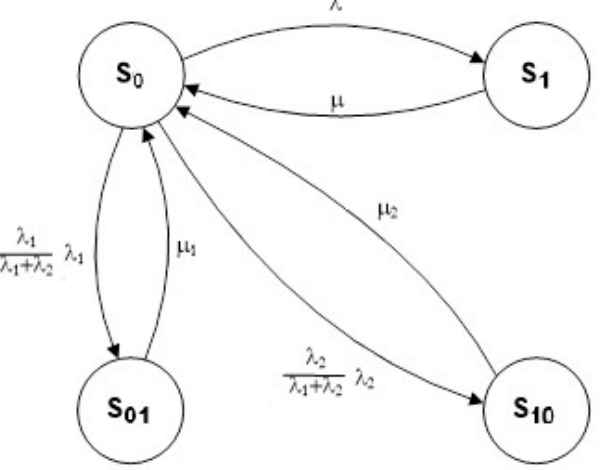
Figure 3. Diagram of the operation process of a wind equipment farm that is not provided with any intelligent WPPES safety decision support systems (model B).